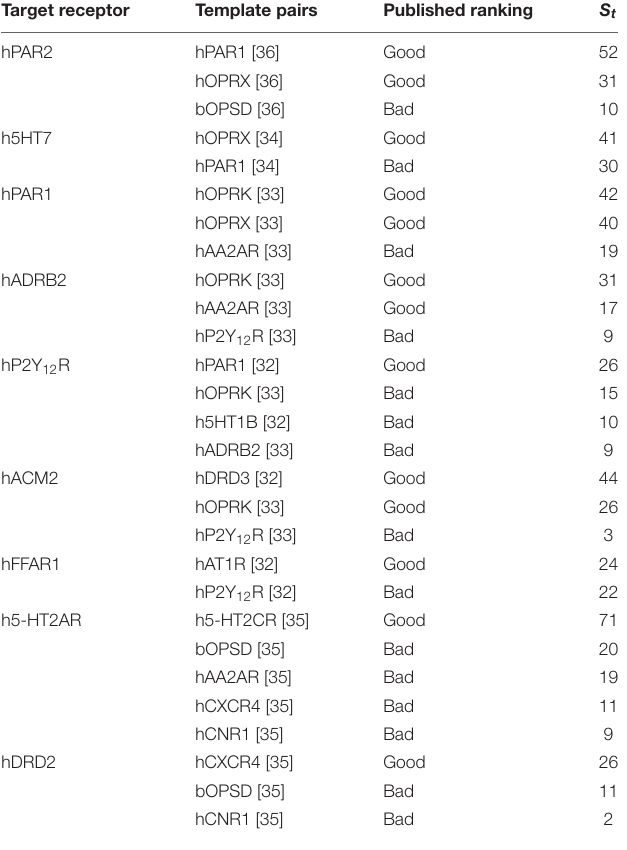
TABLE 1 | Performance of Bio-GATS on recent published target-template pairs. Target receptor